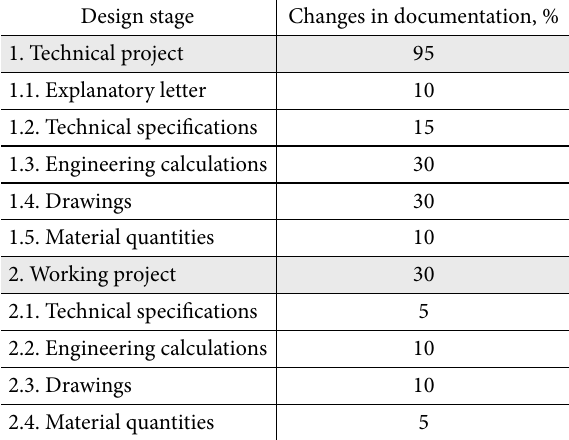
Table 2. Rough estimate of total changes in the example